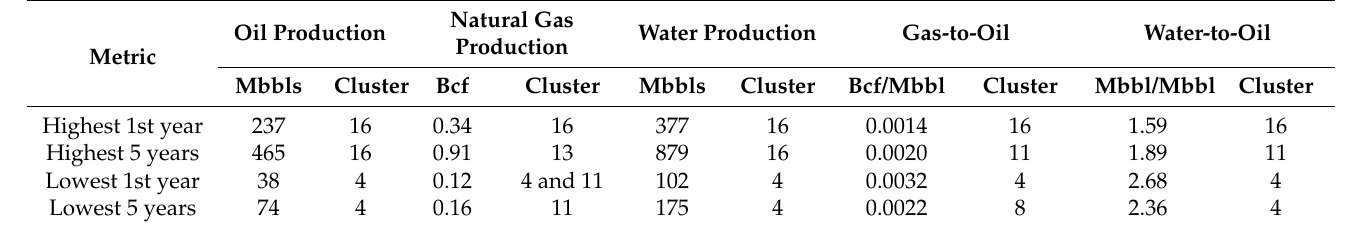
Table 7. Summary of the highest and lowest predicted production totals and associated cluster